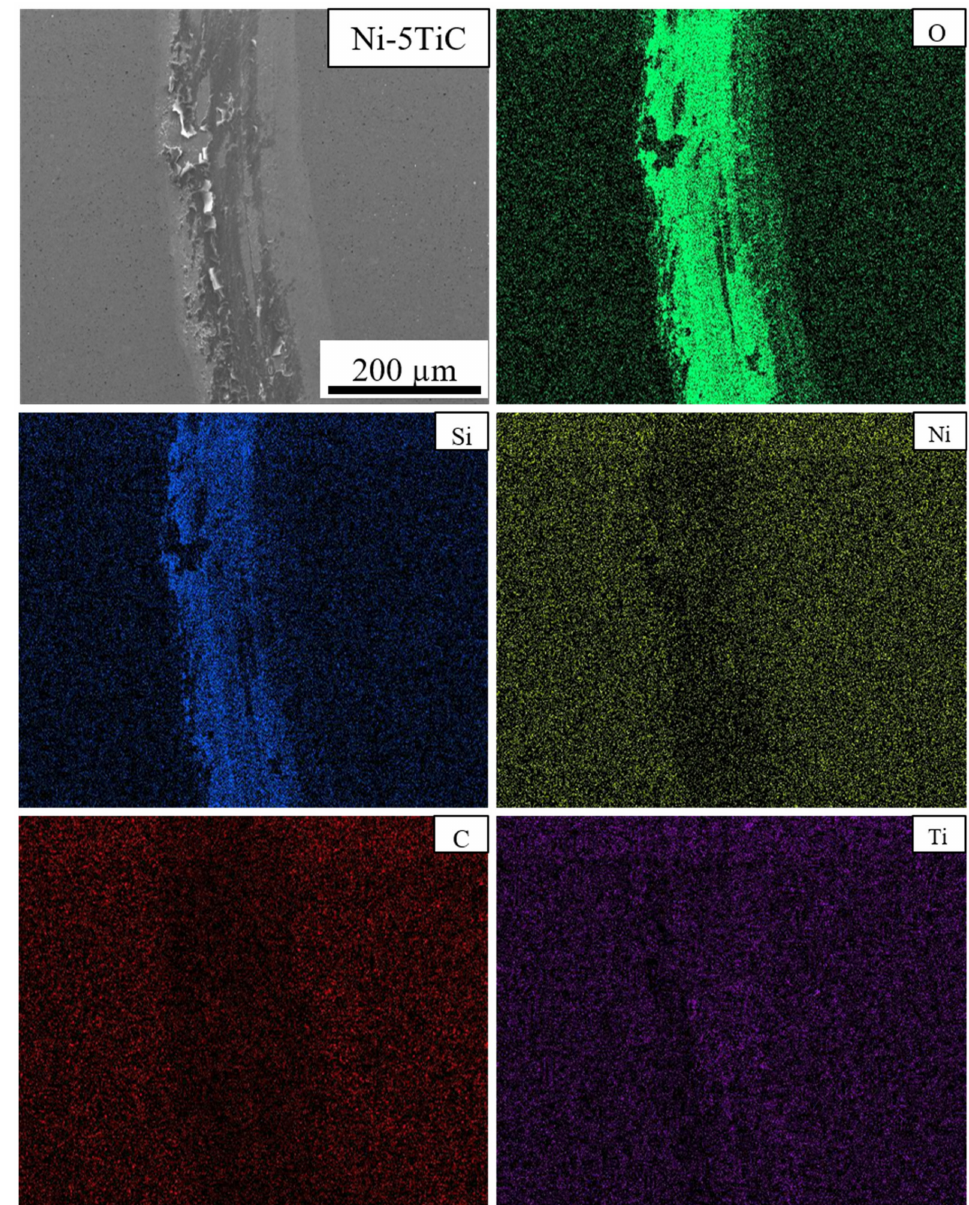
Figure 10. Wear Track EDS Map of